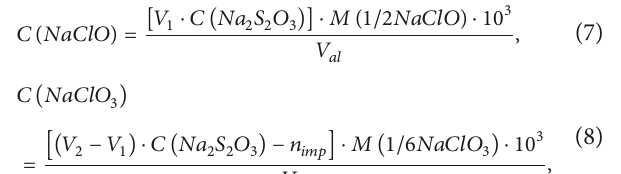
Table 3: The results of the determination of sodium hypochlorite and sodium chlorate (N = 5, P = 0.95). NaClO solution